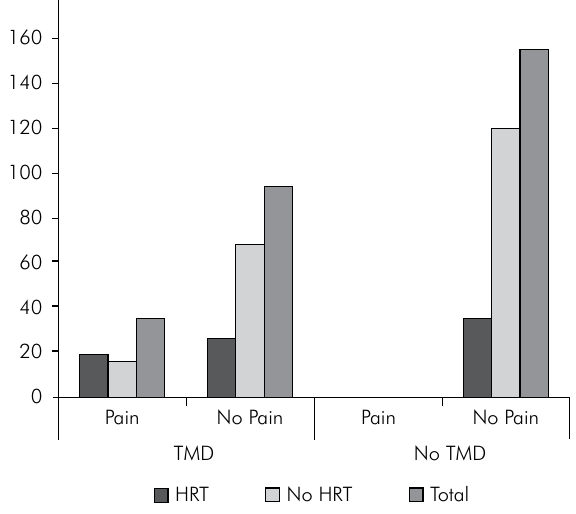
Figure 1. TMD, pain, and HRT relationship.